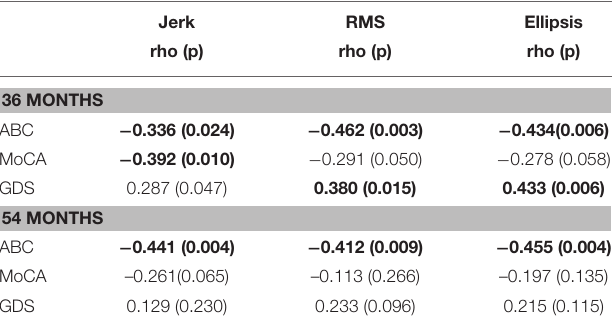
TABLE 4 | Pearson’s correlation coefficient for change in mean postural dynamic parameters of 120s jerk, 30s RMS, and 30s ellipsis with change in clinical